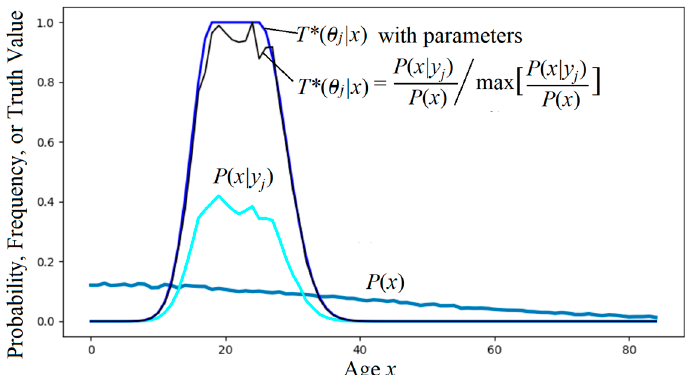
Figure 9. Using prior and posterior distributions P ( x ) and P ( x | y j ) to obtain the optimized truth function T* ( θ j | x